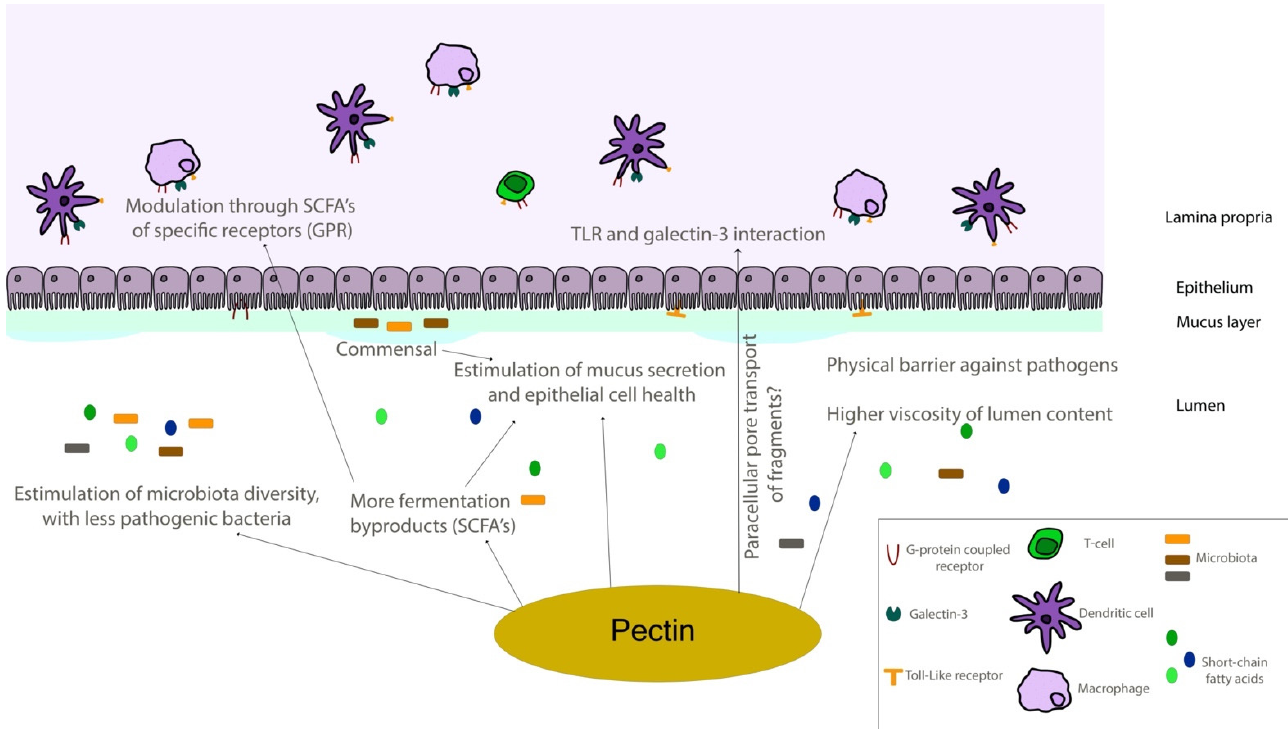
Figure 6. Schematic representation of the intestinal environment. Pectin molecules can interact in different ways with epithelial and immune components of intestinal tissues, regulating different responses directly and through fermentation by-products. SCFA—short-chain fatty acid; TLR—toll- like receptor.